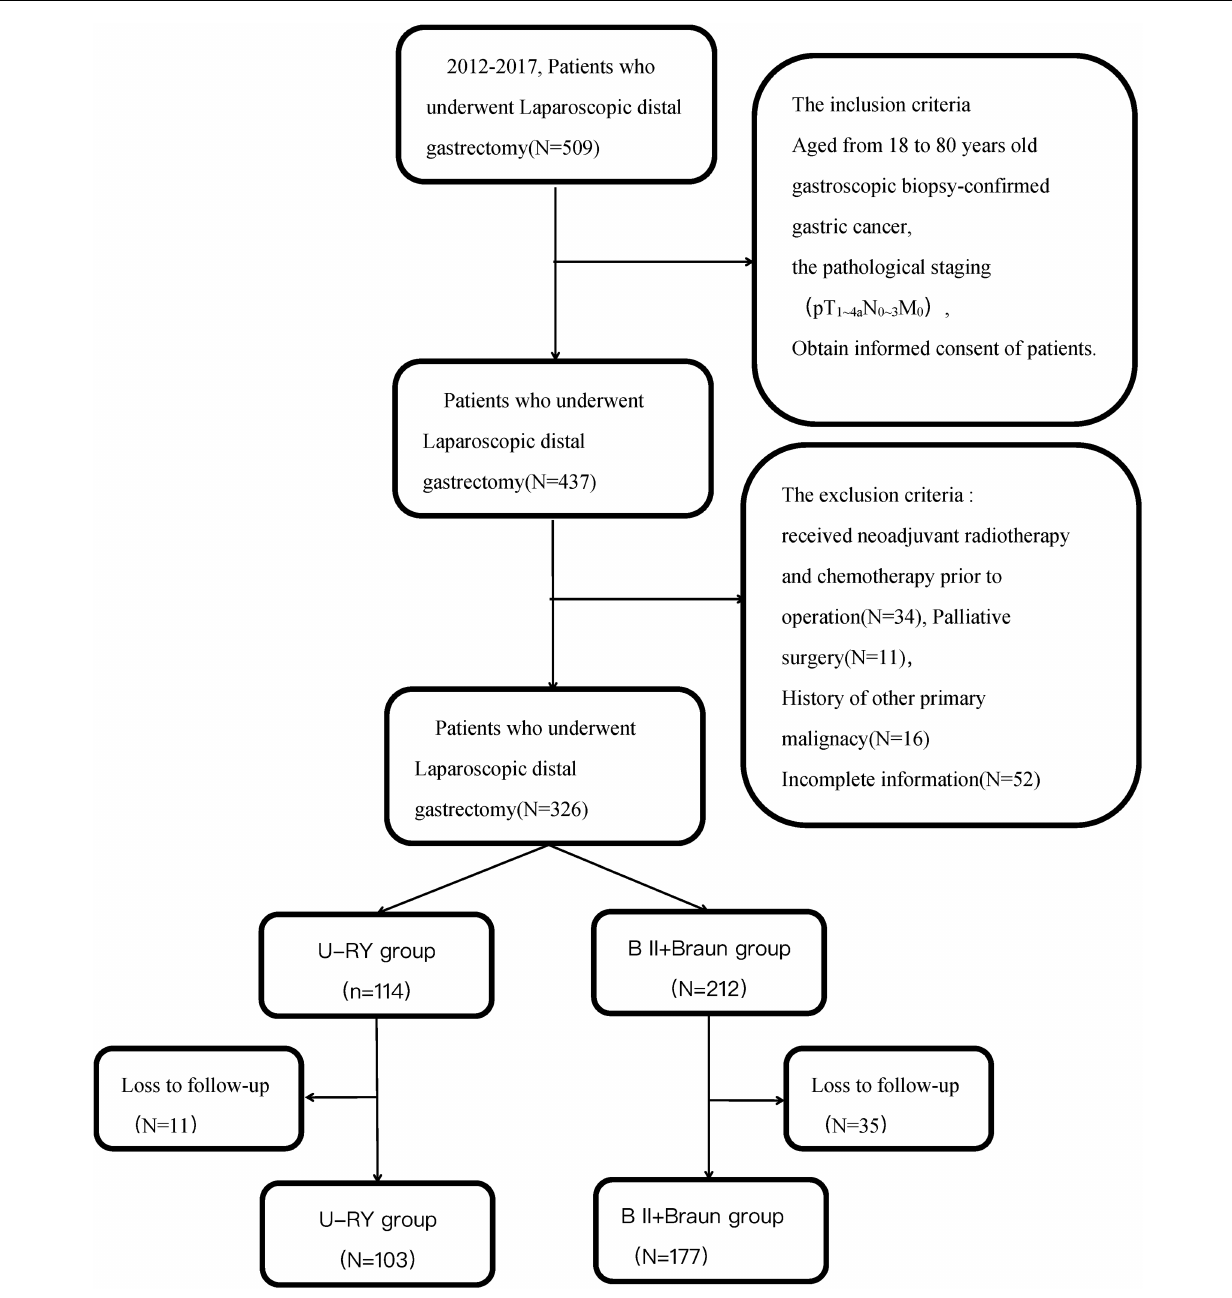
FIGURE 1 Flowchart of the study, 280 patients were included in this